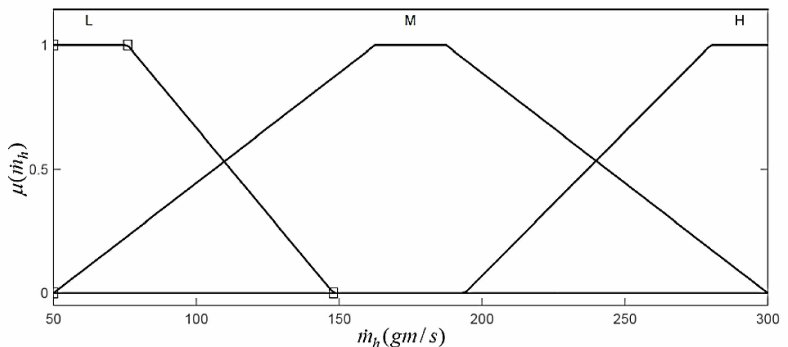
Figure 15. Membership functions of hot fluid mass flow